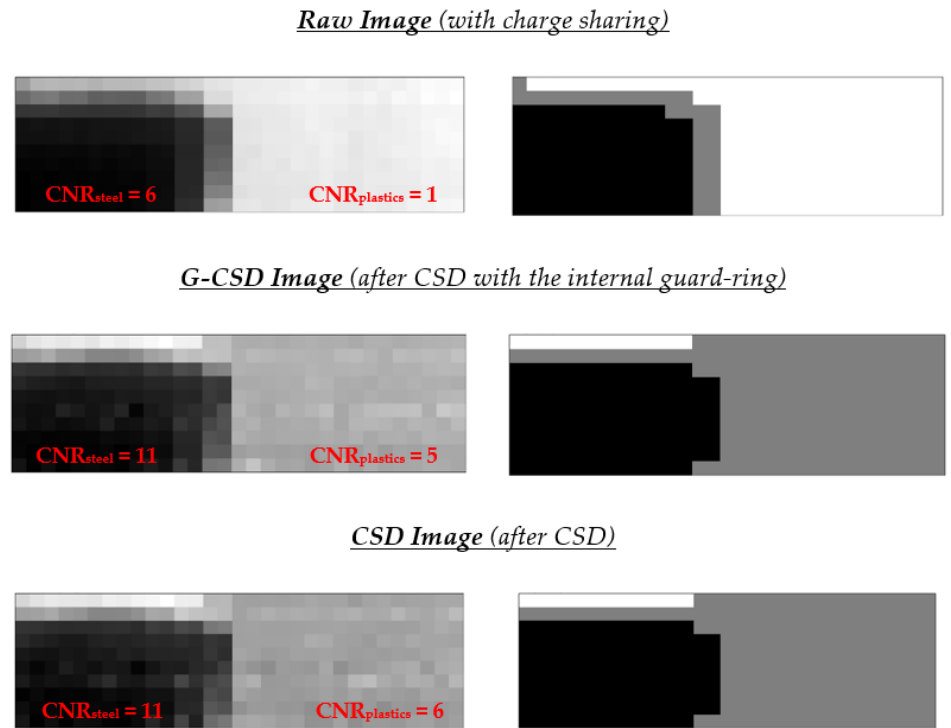
Figure 15. On the left side, the grayscale raw, the G-CSD and the CSD images from the tested phantom, presented in photon counting (PC) mode. On the right side, the results of the material segmentation (k-means clustering): the gray zone for coffee, white for plastics and black for steel. The segmentation is well done after partial (G-CSD) and total rejection (CSD) of the charge sharing events, while a poor segmentation is obtained with the raw image (on the first row of the right-side column). The CNR values are also